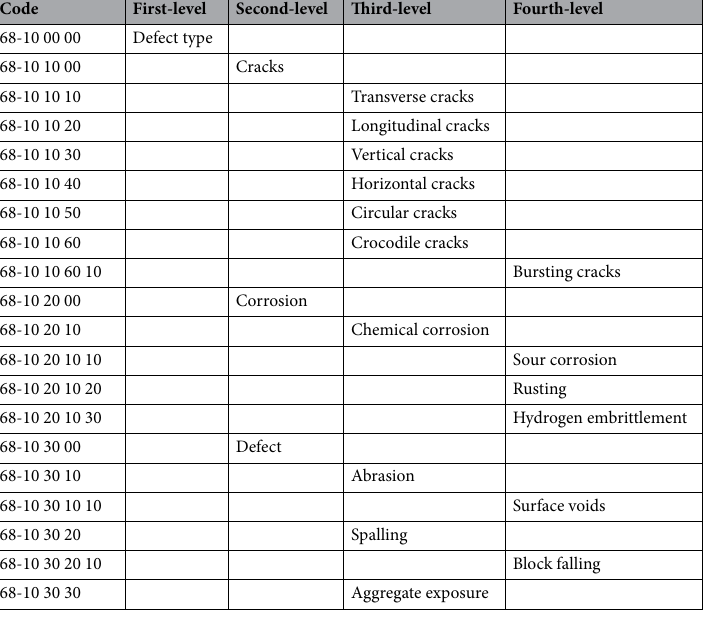
Table 3. “68-Bridge defect characteristics” coding